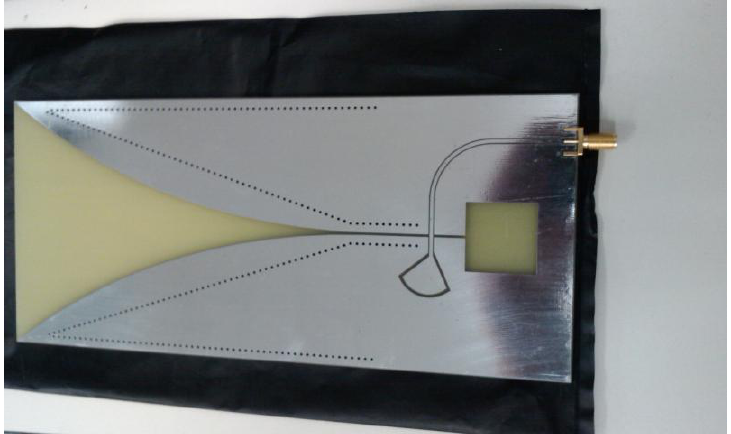
Figure 3. Wideband planar fan beam antenna.